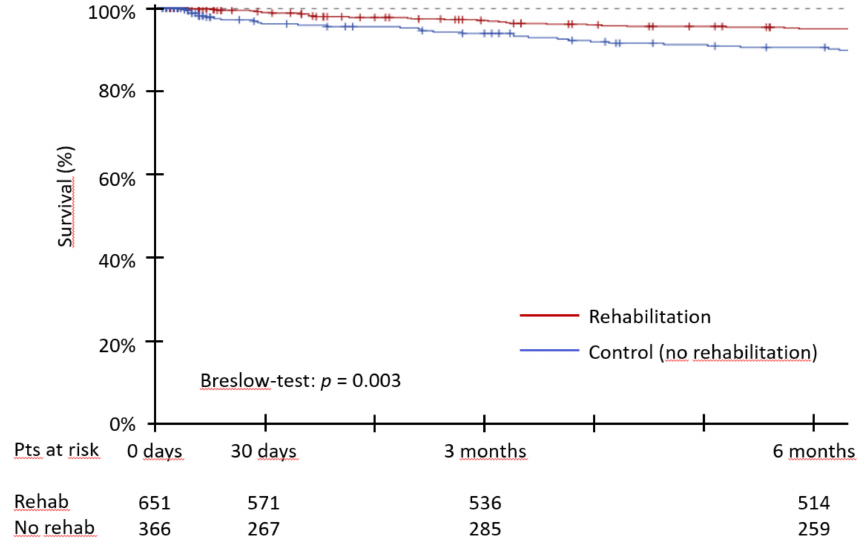
Figure 2. Overall survival during the first six months after TAVI. Kaplan-Meier survival curves for rehabilitation and control (no rehabilitation)